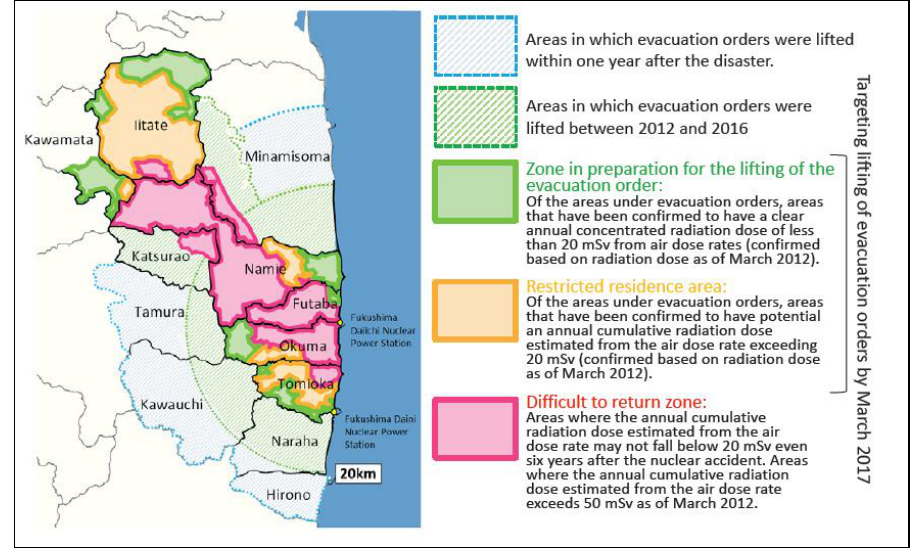
Figure 1. Evacuation areas around the Fukushima nuclear power plant by late 2016 [44].